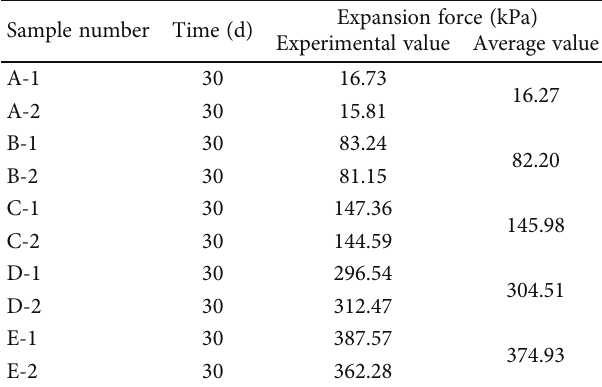
Table 5: Ultimate expansion force test results.